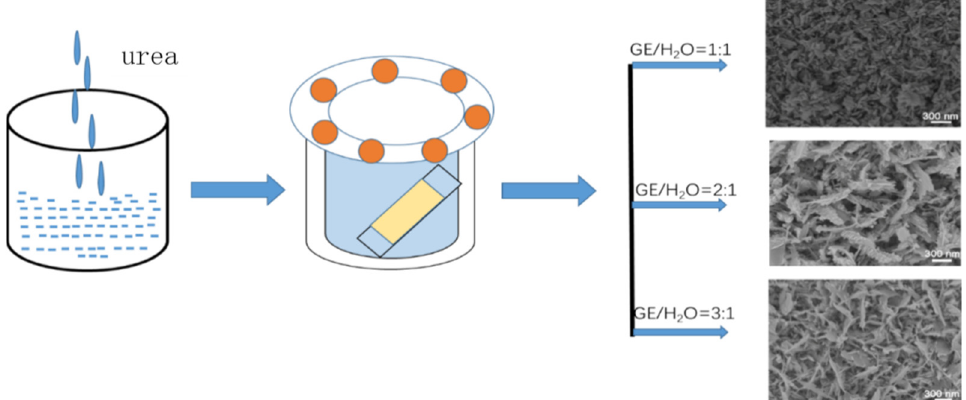
Figure 2. SEM images of the WO 3 films prepared with different solvent ratios. ( a , b ) H 2 O/EG = 1/1, ( c , d ) H 2 O/EG = 1/2, ( e , f ) H 2 O/EG = 1/3. Insets in b, d, and f are cross-sectional view SEM images of the corresponding samples.